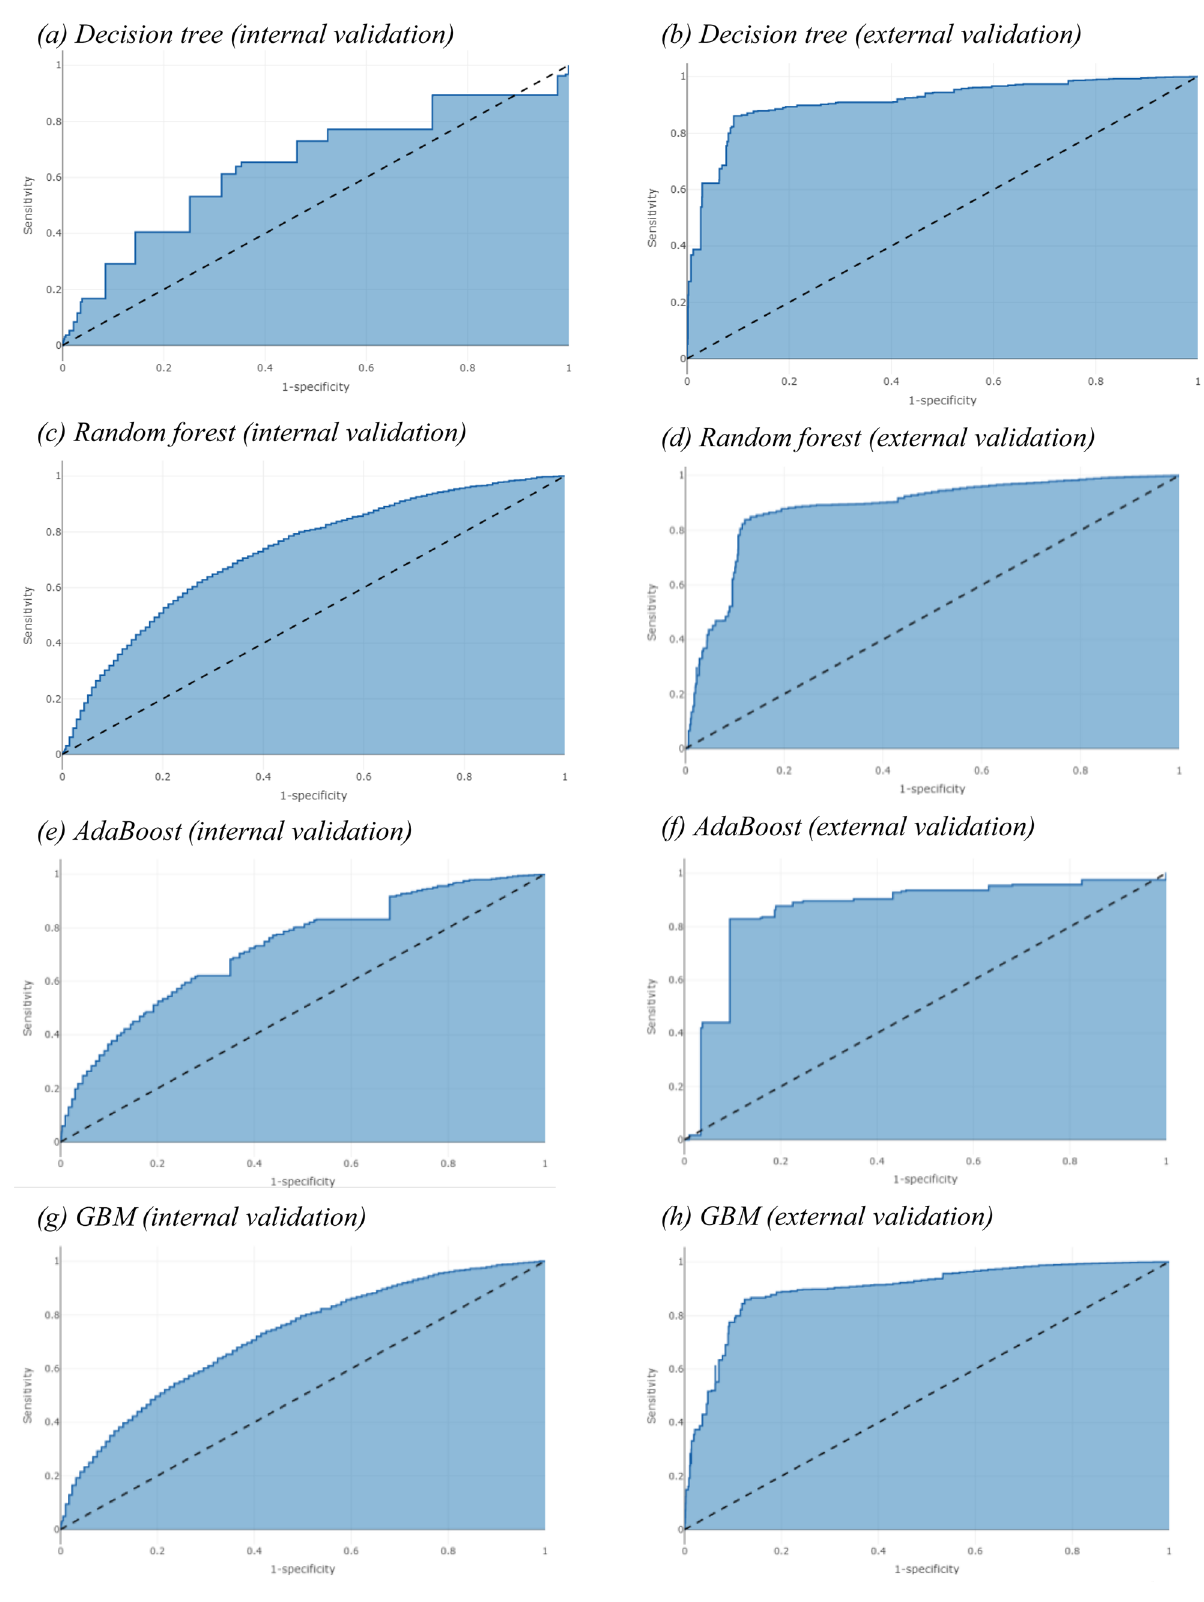
Figure 1. ROC curves for the validation of the Adaboost and decision tree